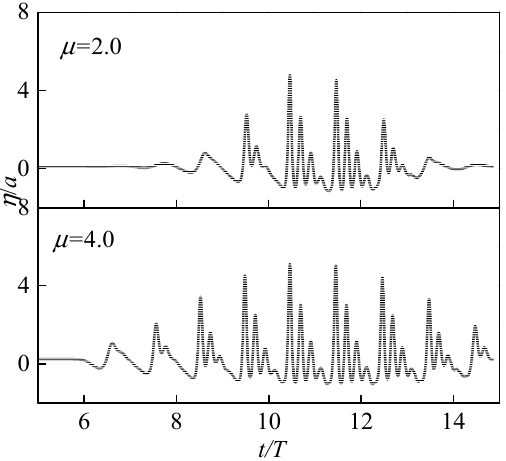
Figure 16. History of wave run-up along the vertical wall for multi-crest wave train cases of different wave frequencies.